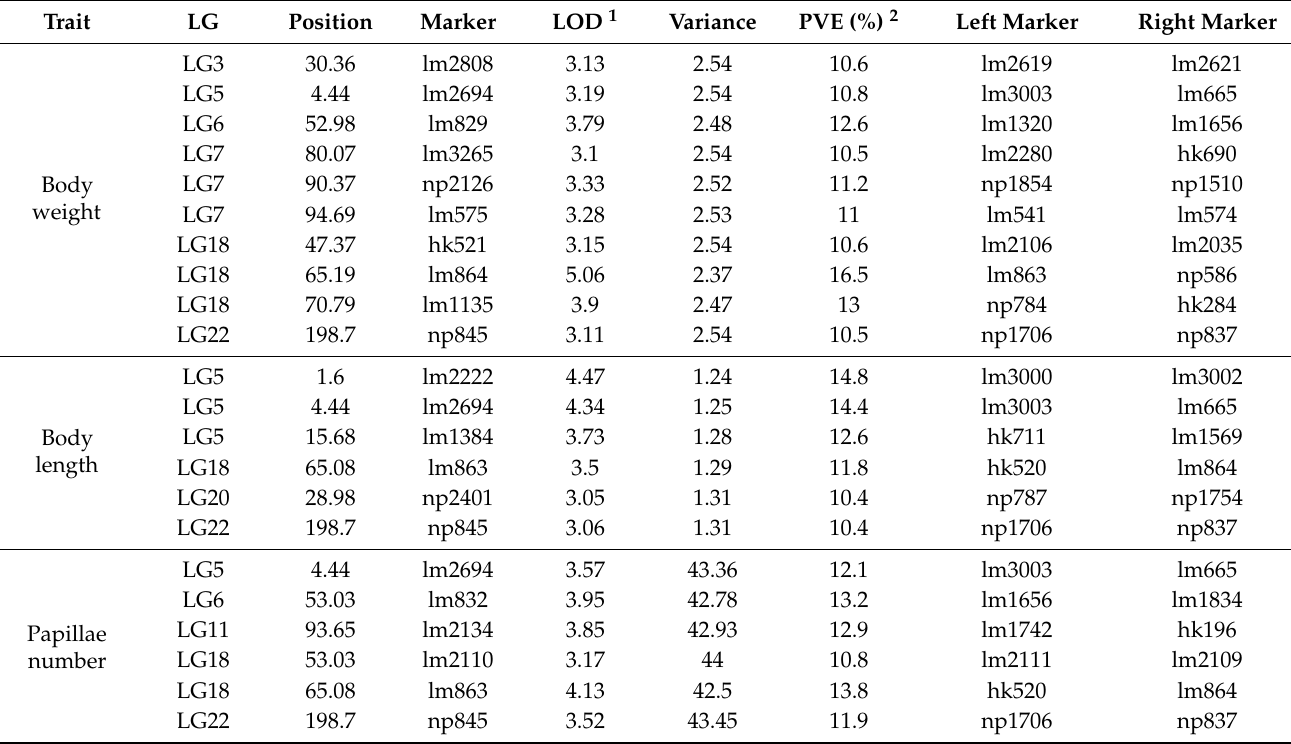
Table 3. Summary of growth-related